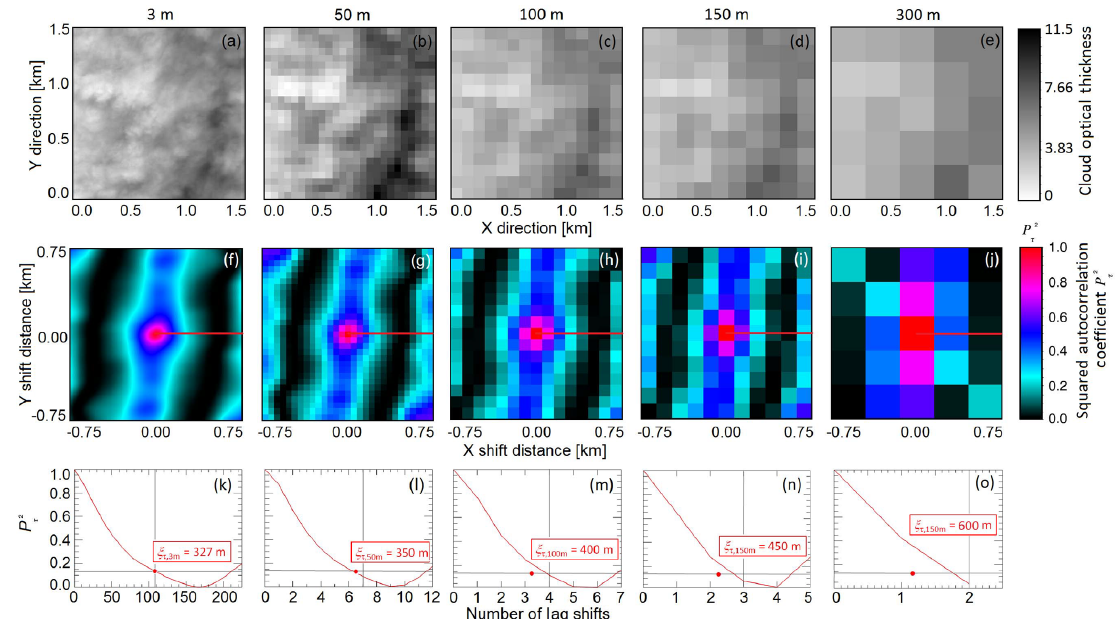
Figure 5. Illustrated are sections of one and the same field of τ meas from 14 May 2012 with a spatial resolutions of (a) ≈ 3m (original resolution), (b) 50m (COSMO resolution), (c) 100m (COSMO resolution), (d) 150m, and (e) 300m. (f–j) Squared 2-D autocorrelation coefficients P 2 τ calculated for the fields of τ meas displayed in panels (a) to (e) . (k–o) Squared 1-D autocorrelation coefficients P 2 τ calculated along straight red line in panels (f) to (j) . Estimated decorrelation length ξ τ is marked by horizontal and vertical black lines and labeled by its value. Red dot marks ξ τ as derived from the case with the original spatial resolution of